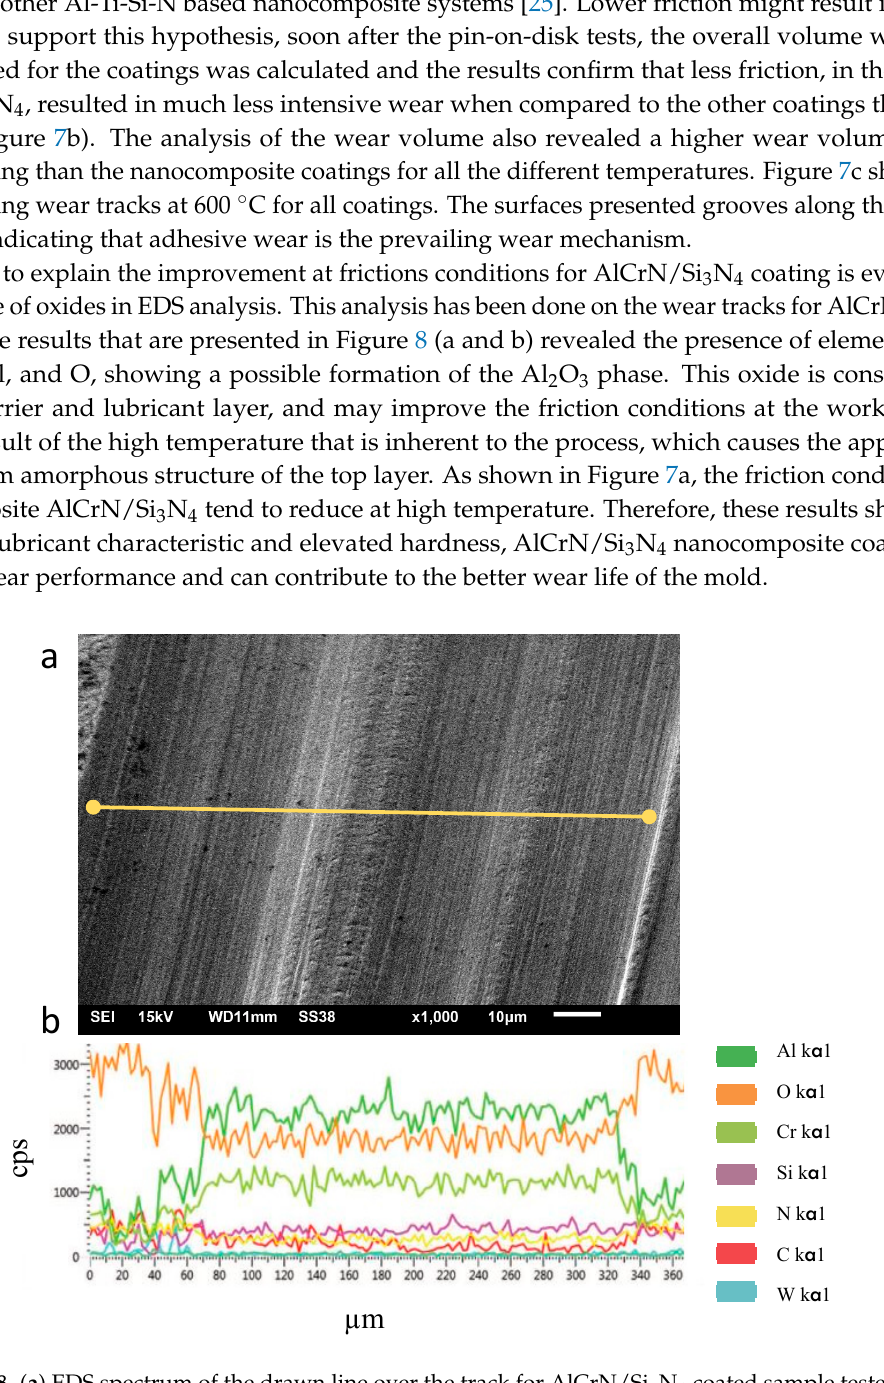
Figure 8. ( a ) EDS spectrum of the drawn line over the track for AlCrN/Si 3 N 4 coated sample tested at 600 °C and ( b ) spectrum lines.